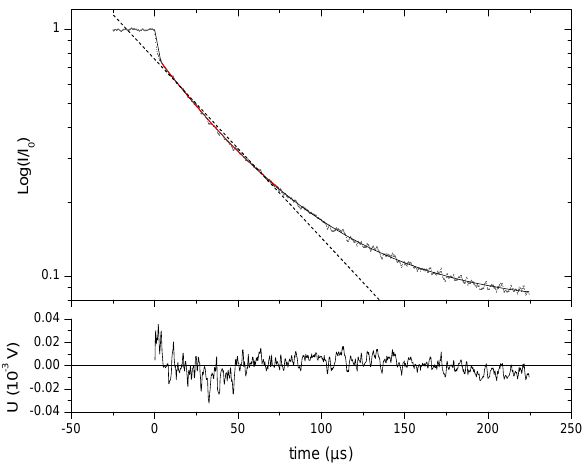
Fig. 2. Ring-down signal averaged from 1000 cycles. Small dots: Figure 2. Ring-down signal averaged from 1000 cycles. Small dots: measurement data. Solid 3 measurement data. Solid line: simulation result from Eq. (4b). line: simulation result from eq. (4.2). Dashed line: single-exponential fit (5 – 75 µs ). Lower 4 Dashed line: single-exponential fit (5–75µs). Lower panel: fit panel: fit residual of multi-exponential fit. Note non-linear decay of Log ( I/I 0 ). 5 residual of multi-exponential fit. Note the non-linear decay of Log( I/I 0 ) .